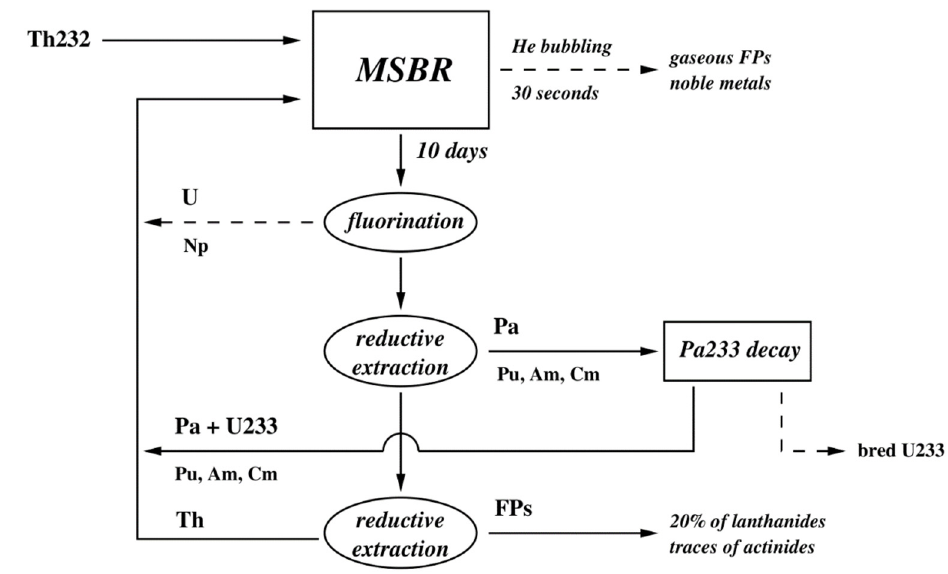
Figure 3. Simplified flow diagram of the MSBR reprocessing unit [22].